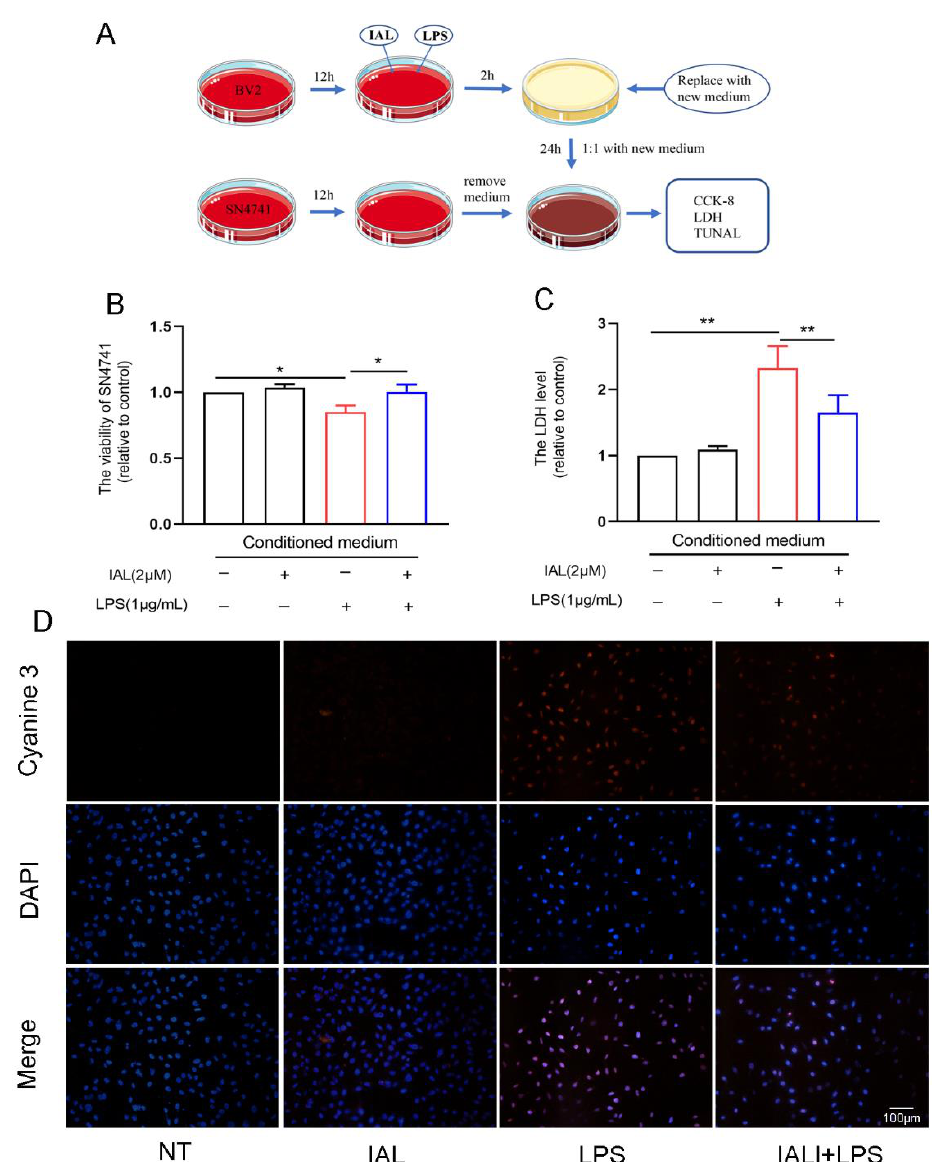
Figure 8. IAL treatment protects SN4741 from microglial activation-mediated neurotoxicity. ( A ) Conditioned medium preparation flow chart. ( B ) The effect of conditioned medium on SN4741 cell viability was examined using the CCK-8 method. ( C ) The effect of conditioned medium on cellular LDH release was examined using the LDH method. ( D ) The effect of conditioned medium on SN4741 cell death was examined using Tunel staining. Results are shown as means ± SEM (n = 3). * p < 0.05 and ** p < 0.01 stand for biologically significant differences.